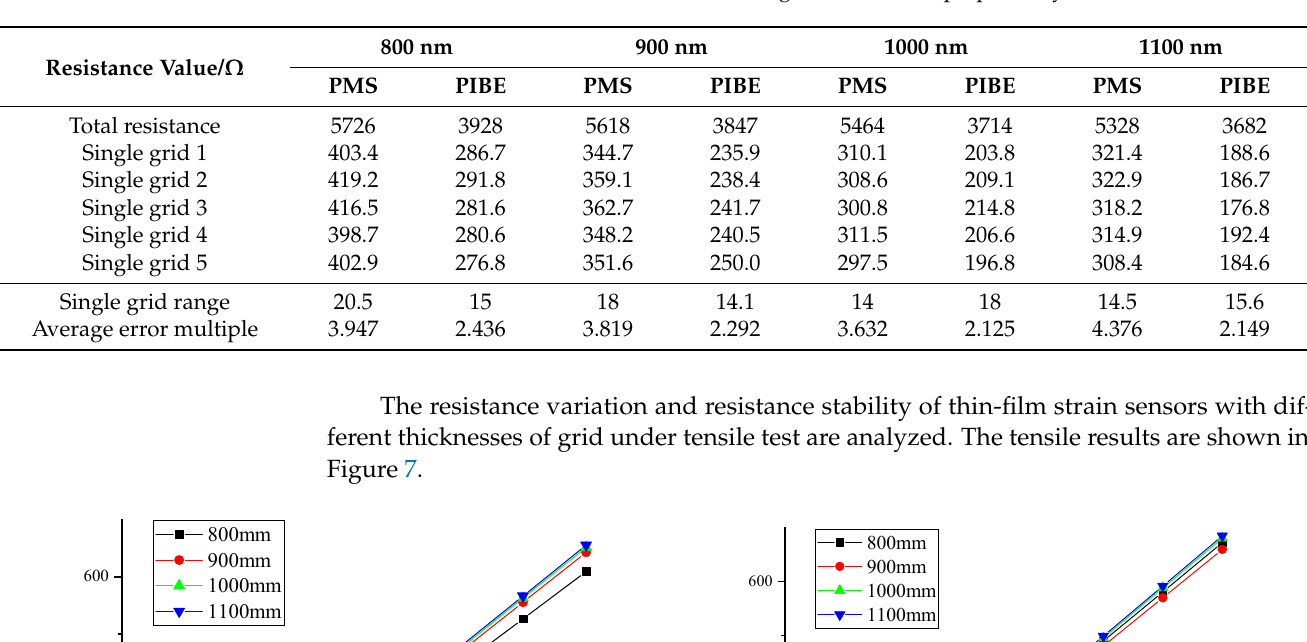
Table 5. Resistance of thin film with different grid thicknesses prepared by PMS and PIBE.